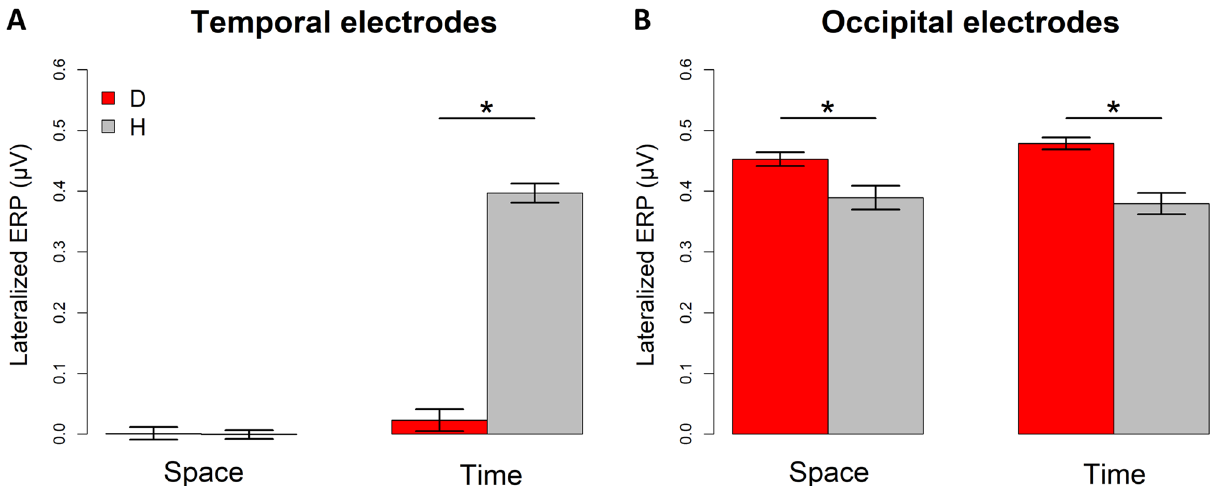
Figure 4. Lateralized (contralateral-minus-ipsilateral) ERP amplitude (mean ± SEM) in temporal and occipital scalp sites in the time window between 50–90 ms after the second flash of space and time bisection tasks. ( A ) temporal electrodes (T7/T8); ( B ) occipital electrodes (O1/O2). In grey, hearing participants; in red, deaf participants. The star indicates a significant difference between the groups ( p <